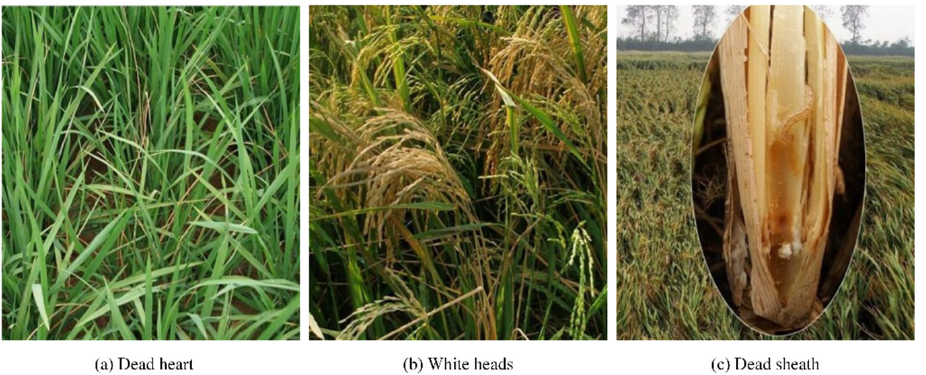
Figure 1. The main symptom in rice of damage by SRSB.